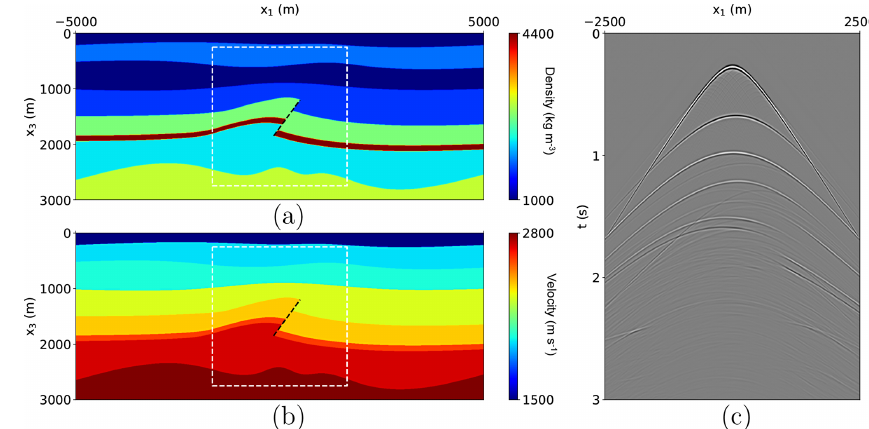
Figure 5. (a) Density (kgm − 3 ) and (b) P-wave velocity (ms − 1 ) of the numerical model used to create reflection data. The white box denotes the area of interest for the purpose of homogeneous Green’s function retrieval. The black dashed line indicates a fault plane. (c) Common- source record created using the model data in (a) and (b) , with the source at the top center of the model, using a finite-difference modeling code and convolved with a 30Hz Ricker